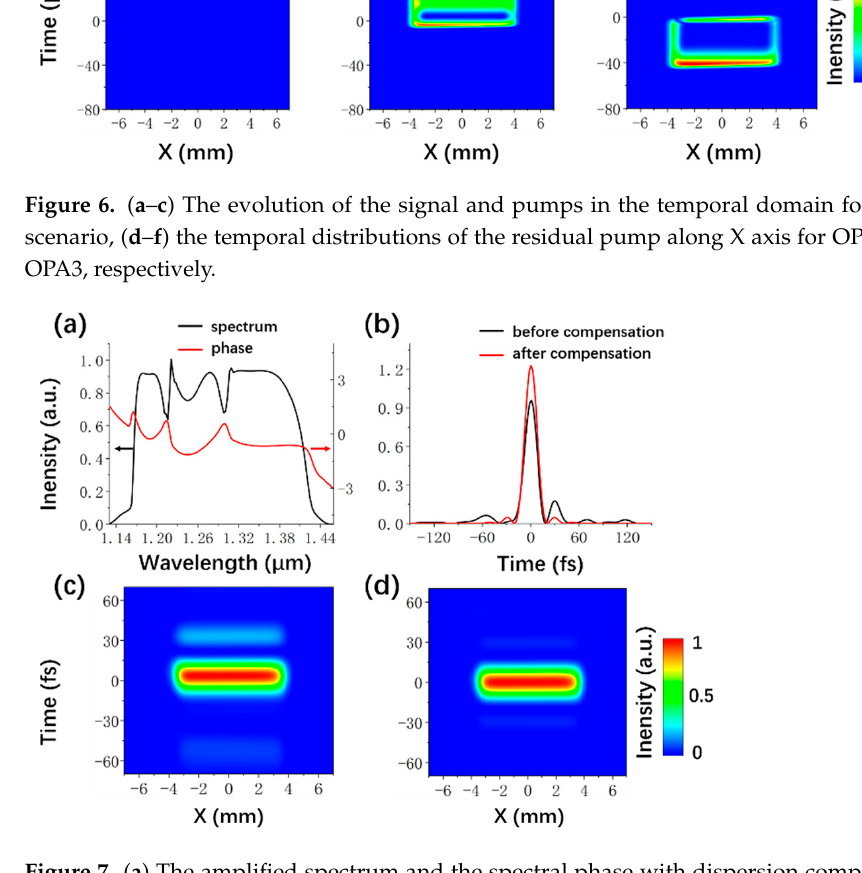
Figure 6. ( a – c ) The evolution of the signal and pumps in the temporal domain for triple-crystal sce- nario, ( d – f ) the temporal distributions of the residual pump along X axis for OPA1, OPA2 and OPA3, respectively.